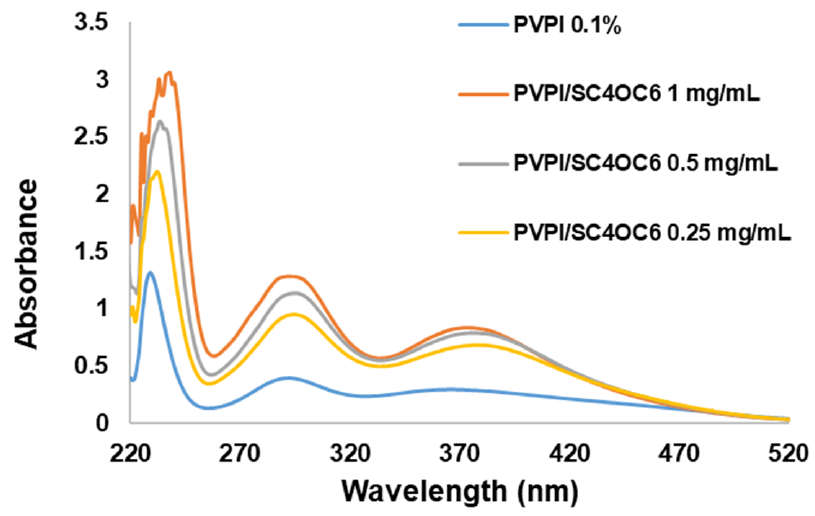
Figure 4. UV-vis spectra of 0.1% PVPI solutions alone and with SC4OC6 (0.25, 0.5, and 1 mg/mL) in PCB.